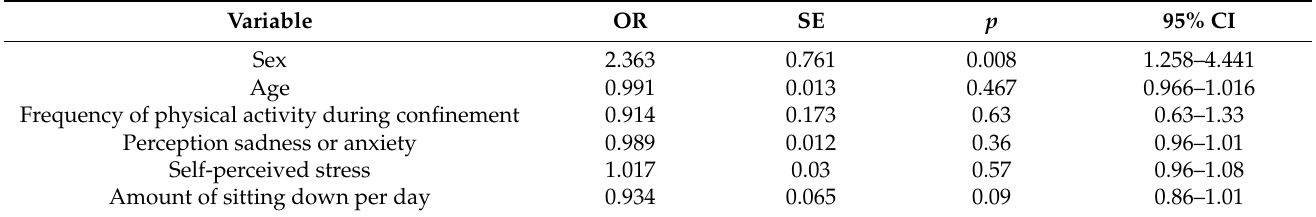
Table 2. Binomial Logistic Regression of musculoskeletal pain in relation to gender, physical activity practice and emotional perception.